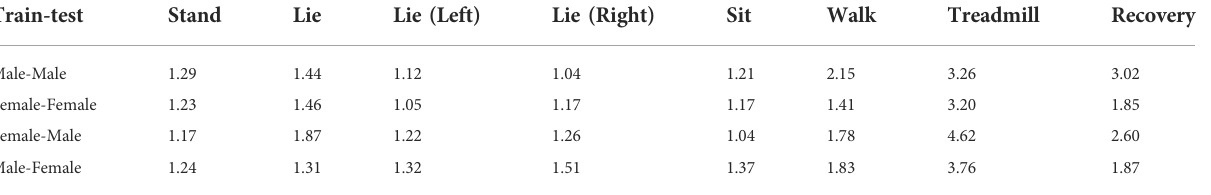
TABLE 6 The effect of gender on predicted results under various tasks. Train-test Stand Lie Lie